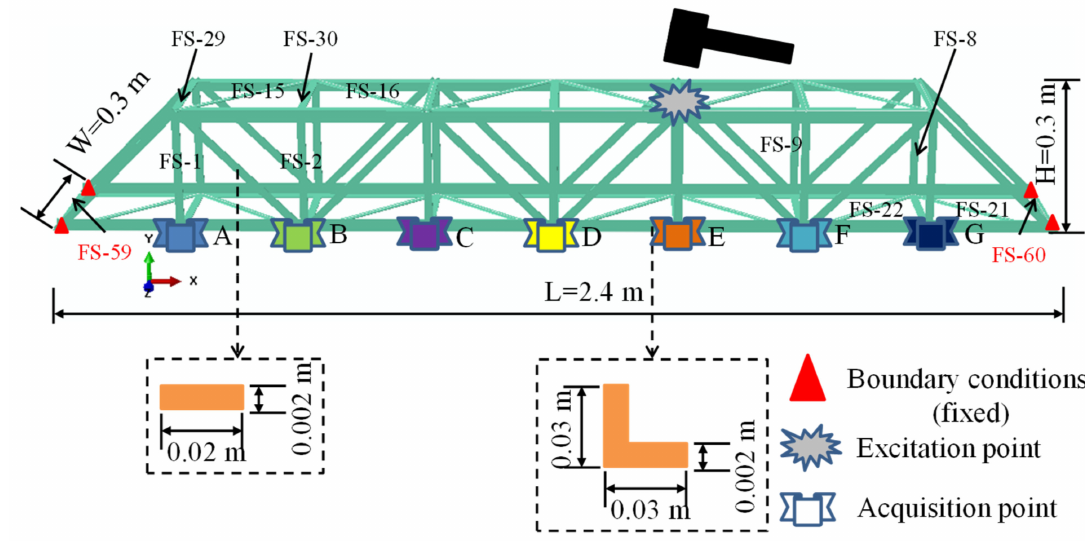
Figure 2. The bridge model with 60 flat steel